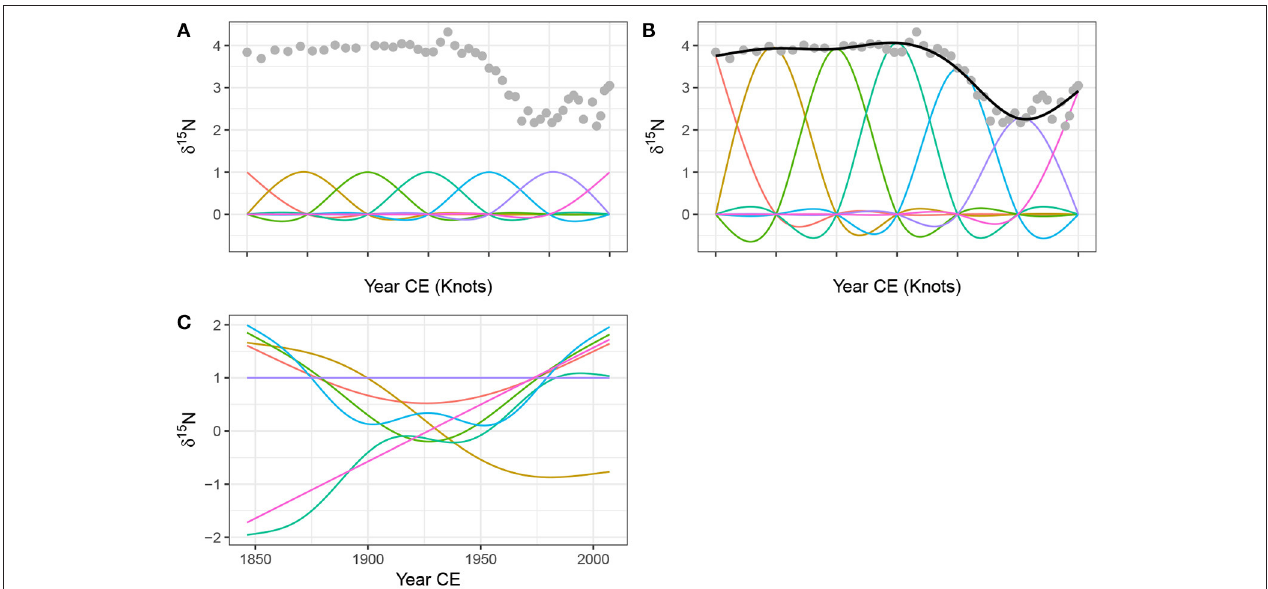
FIGURE 4 | Basis functions for the time covariate and the Small Water δ 15 N time series. A rank (size) 7 cubic regression spline (CRS) basis expansion is show in (A) , with knots, indicated by tick marks on the x-axis, spread evenly through the range of the data. (B) Shows the same CRS basis functions weighted by the estimated coefficients β j , plus the resulting GAM trend line (black line drawn through the data). The grey points in both panels are the observed δ 15 N values. (C) A rank 7 thin plate regression spline basis for the same data.